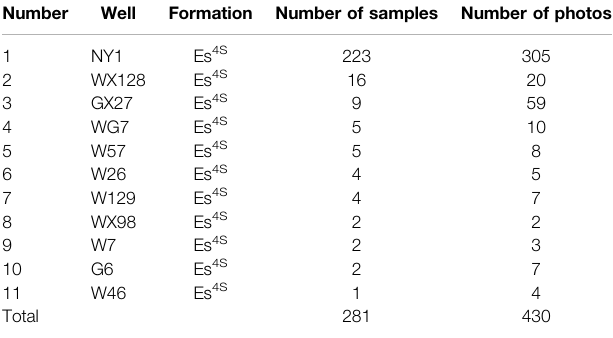
TABLE 1| The number, well name, formation, number ofsamples, and number of photos used in scanning electron microscope (SEM) observation. See Figure 1 for the well location.